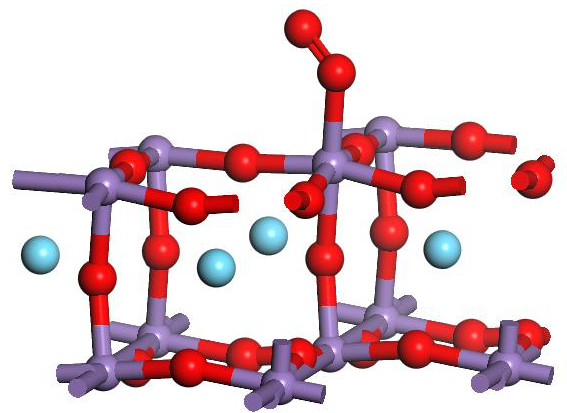
Figure 6. The absorption configuration of O 2 on LaMnO 3 catalyst surface. Table 2. The parameters of O 2 adsorption configuration.